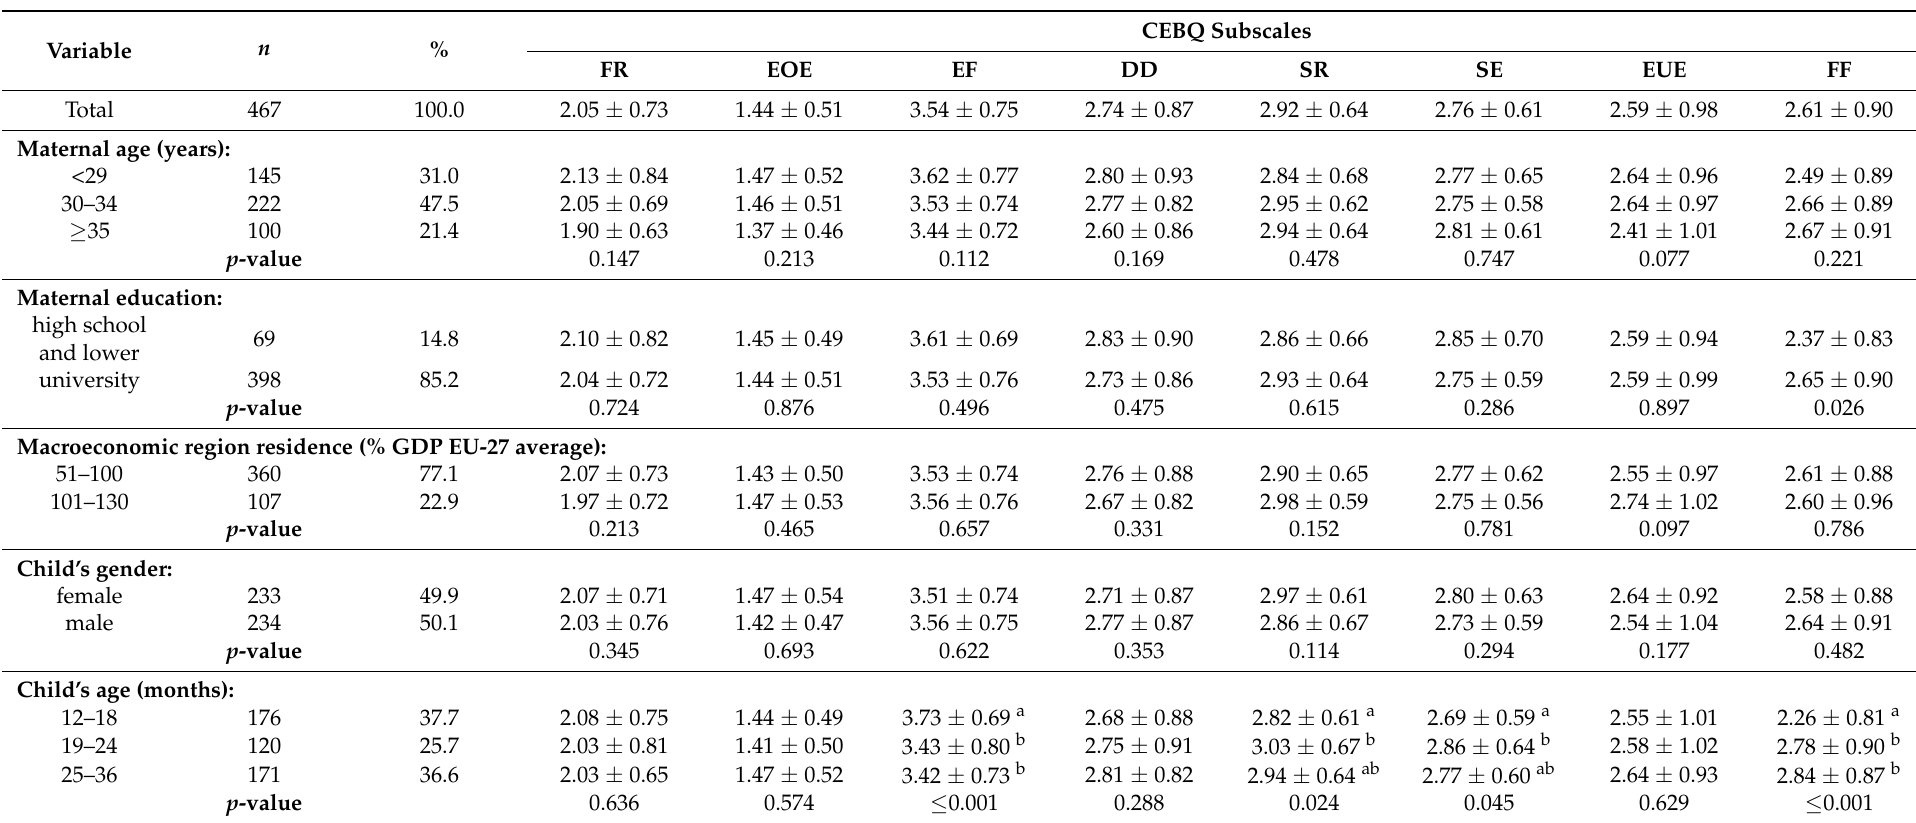
Table 1. Sociodemographic characteristics of the study sample according to CEBQ